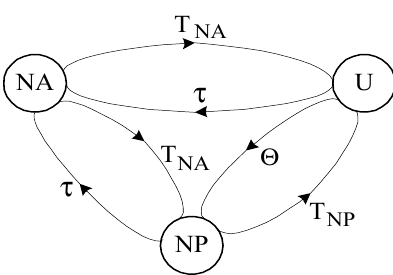
Figure 1. Graph of a model of an object’s operation process with a servicing system which uses an artificial neural network which processes diagnostic information expressed in a trivalent evaluation of states.